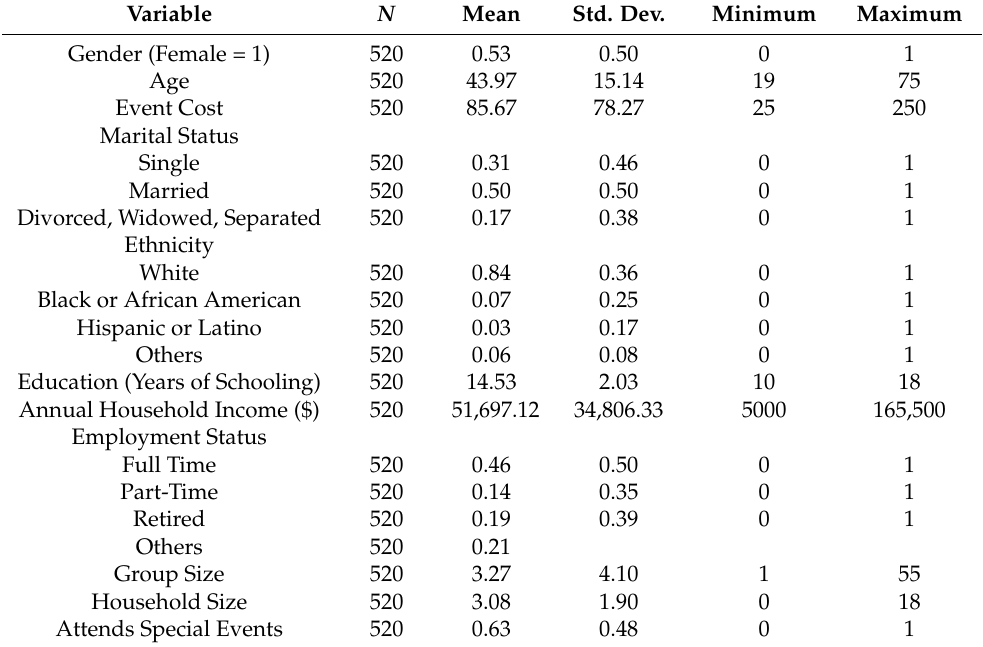
Table 1. Survey respondent profile.